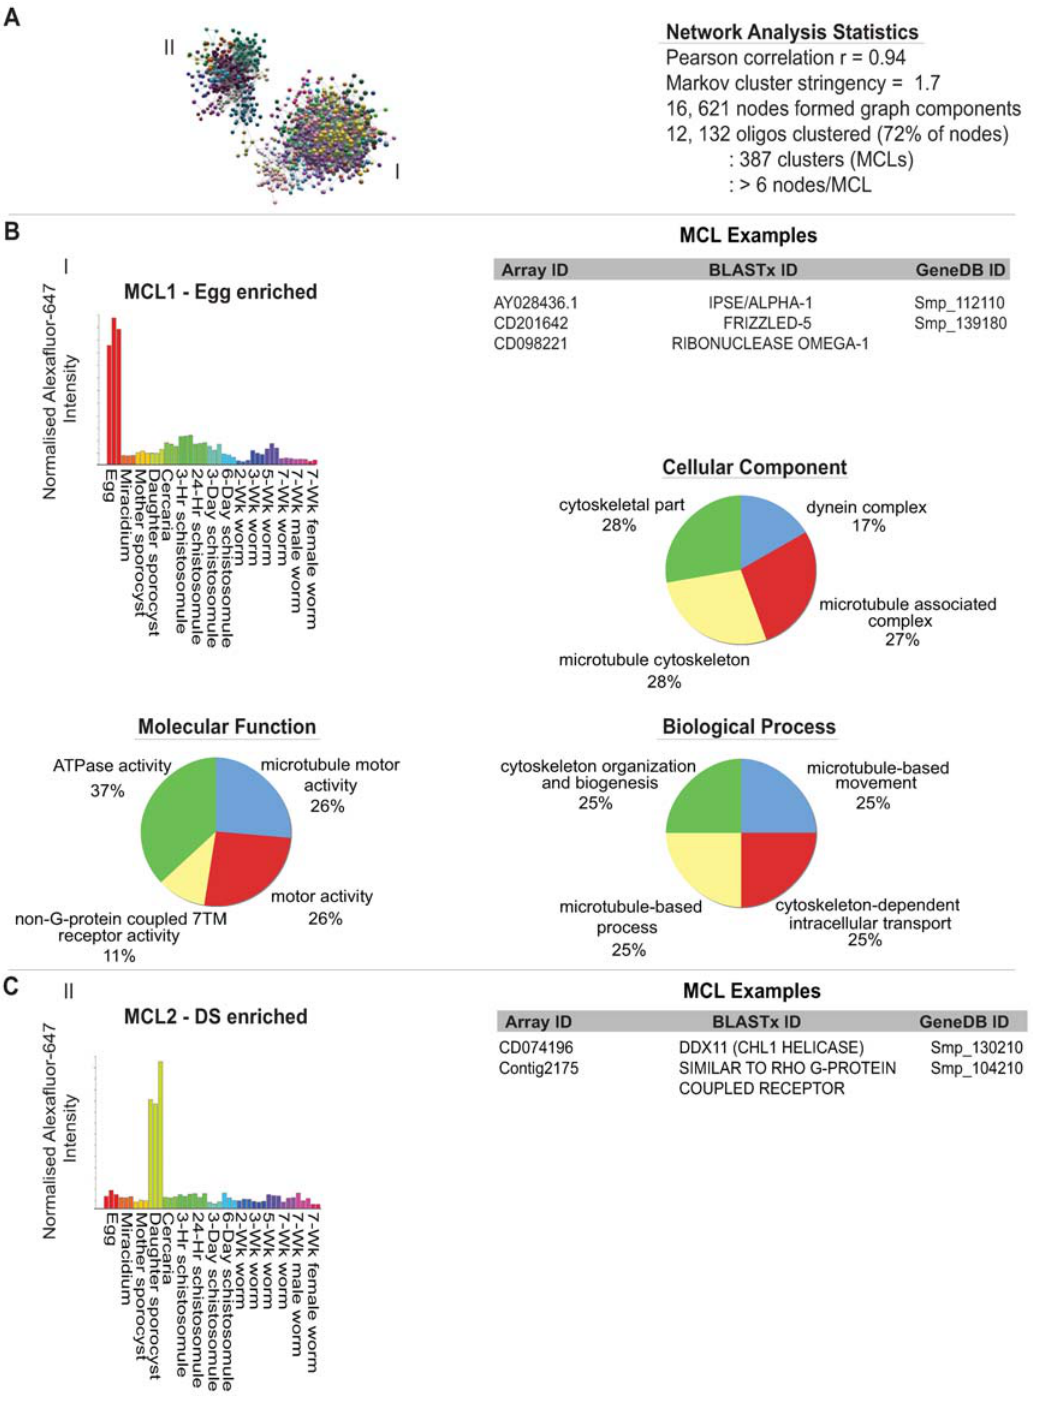
Figure 4. Network analysis of the schistosome lifecycle identifies egg and daughter-sporocyst enriched transcripts. Network analysis was performed as described in Methods using the BioLayout Express 3D package [29]. A) One network graph component containing two major clusters is illustrated (I; egg enriched transcripts and II; daughter sporocyst enriched transcripts). Different Markov clusters (MCL) within the network are represented by different coloured nodes (genes). The network analysis was performed using a Pearson correlation of r=0.94 and Markov cluster stringency of 1.7 with accompanying details indicated. Nodes included in the identified 387 MCLs are included in Dataset S6, and form the basis of all subsequent descriptions. B) MCL1 includes transcripts highly enriched in the egg lifecycle stage (I). Some representative MCL gene examples are provided in addition to the GO terms significantly enriched in this cluster. C) MCL2 contains transcripts highly enriched in the daughter sporocyst lifecycle stage (II). Some representative MCL gene examples are provided. Bar graphs represent average normalised AF647 intensity values (Dataset S4) for all transcripts in that cluster, with replicate values obtained from independent life-stage hybridizations indicated as identical colours.